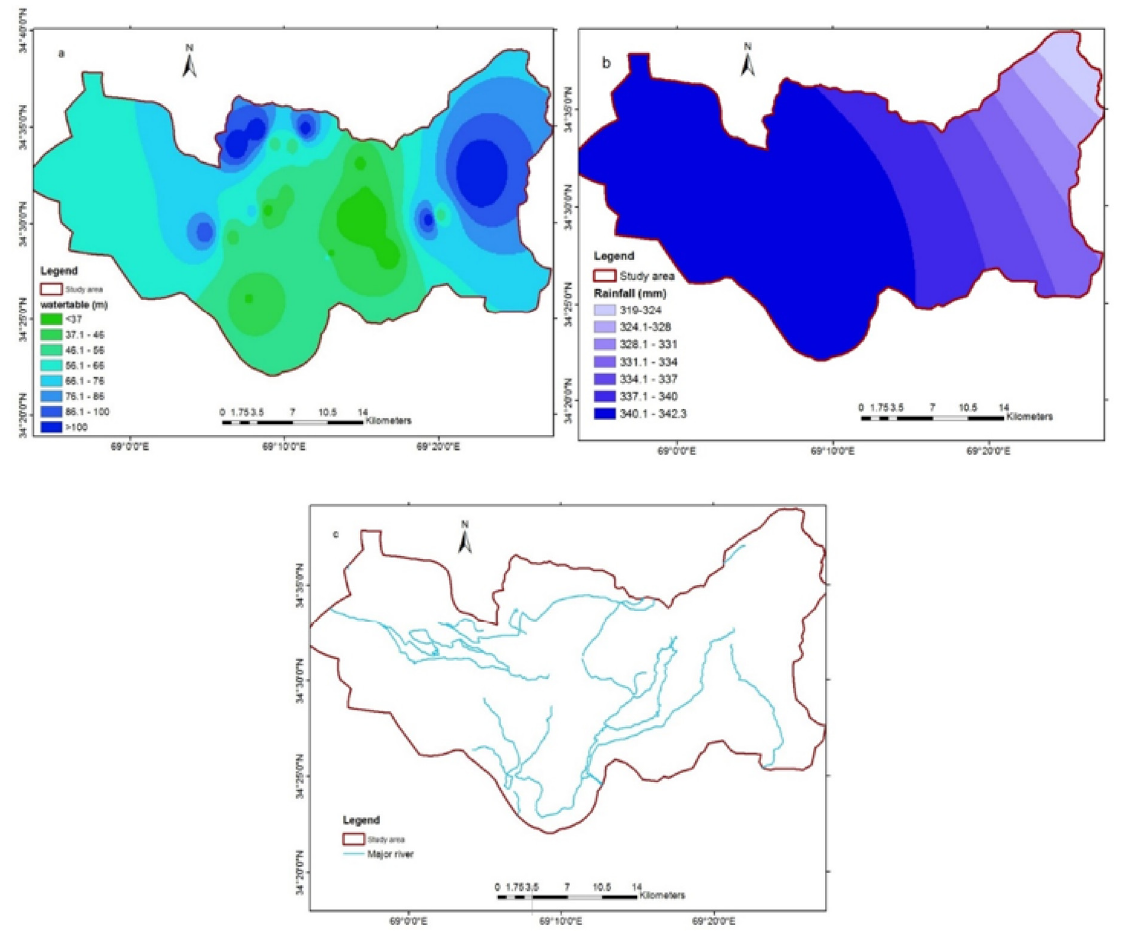
Figure 6. Water resource contribution to the area: ( a ) water table; ( b ) rainfall; ( c ) major